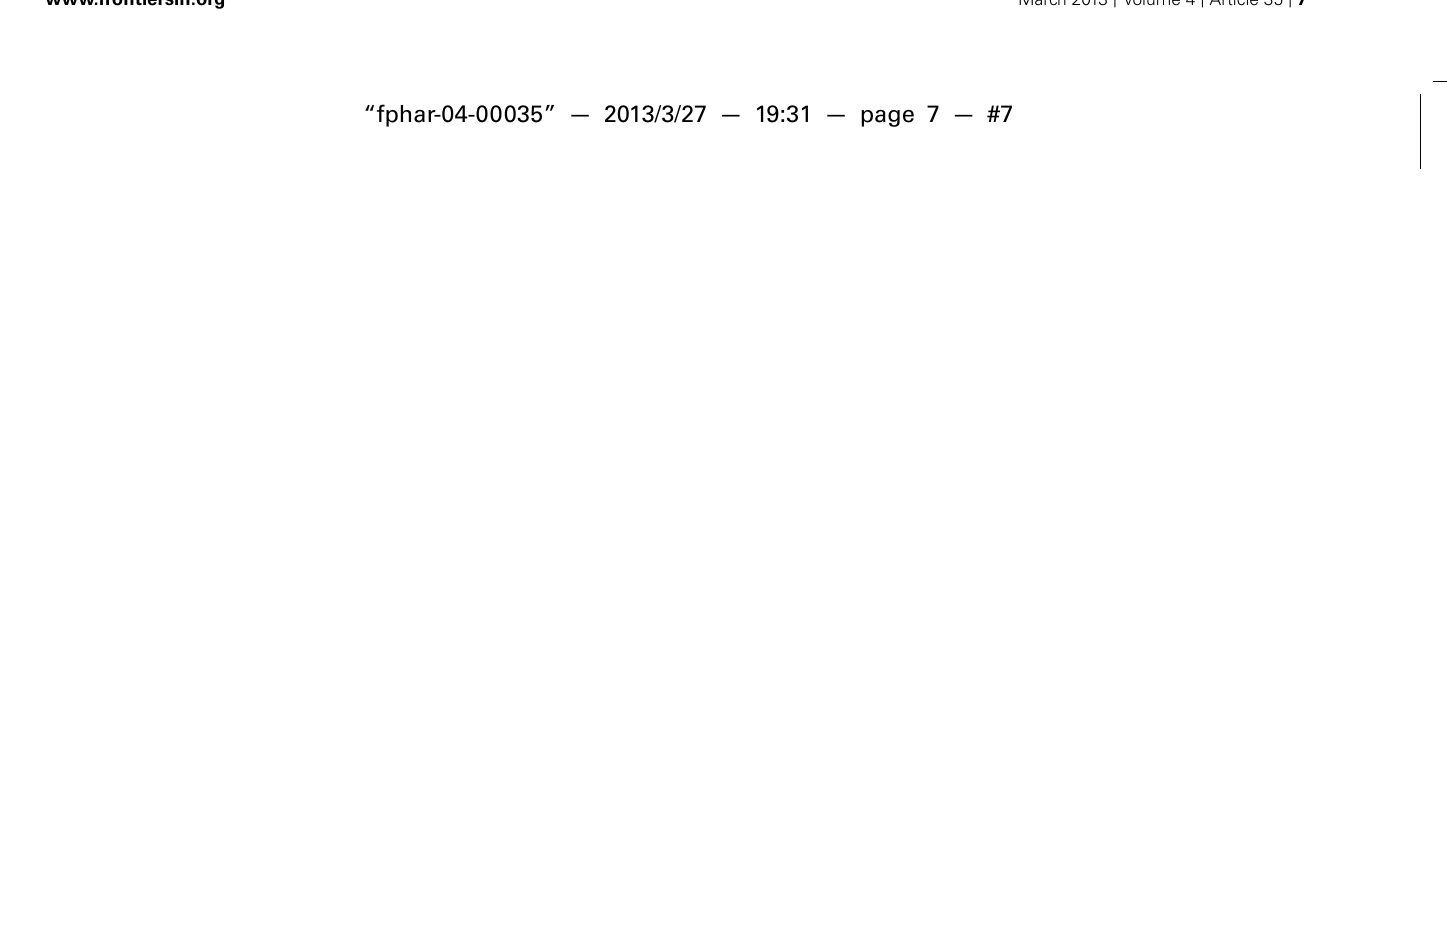
FIGURE 5 | Effects of PF-3758309 on anchorage-independent growth, spheroid formation and migration. (A) HCT116 and GEO were plated in a soft agar assay untreated or treated with 15 nmol/L of PF-3758309 for 14 days. (B) HCT116 and GEO were plated in 3D culture in matrigel to observe spheroid formation. (C) Quantification of spheroid formation of two sensitive and two resistant cell lines.The average spheroids from